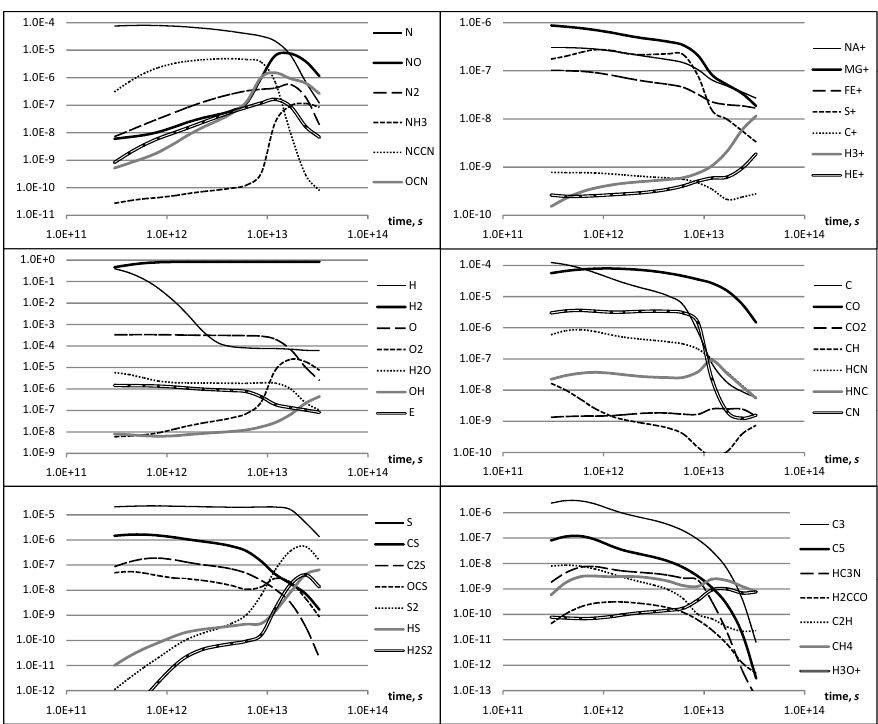
Fig. 2. Calculated gas-phase relative abundances for selected species for Model 2 (with freeze processes). Pay attention to the relative abundance (ordinate) scale for each